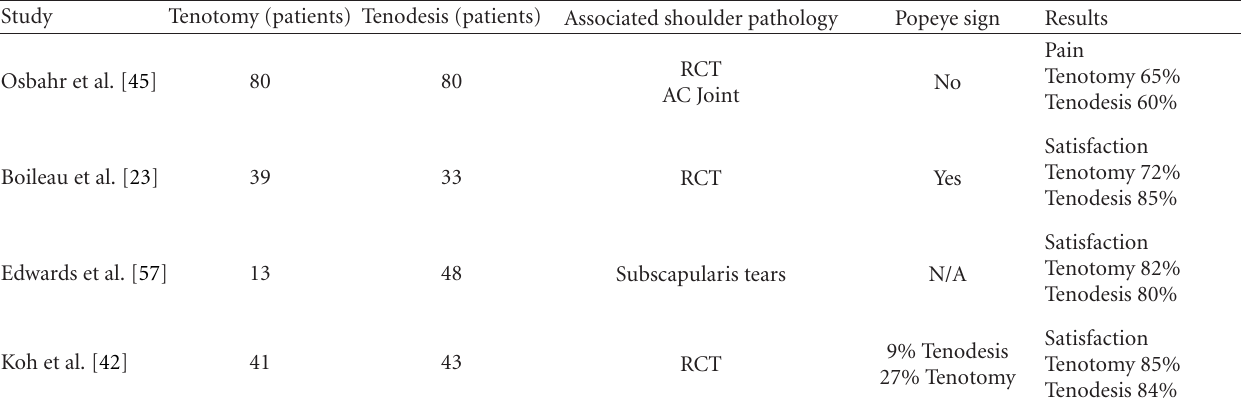
Table 2: Summary of four articles on tenotomy versus